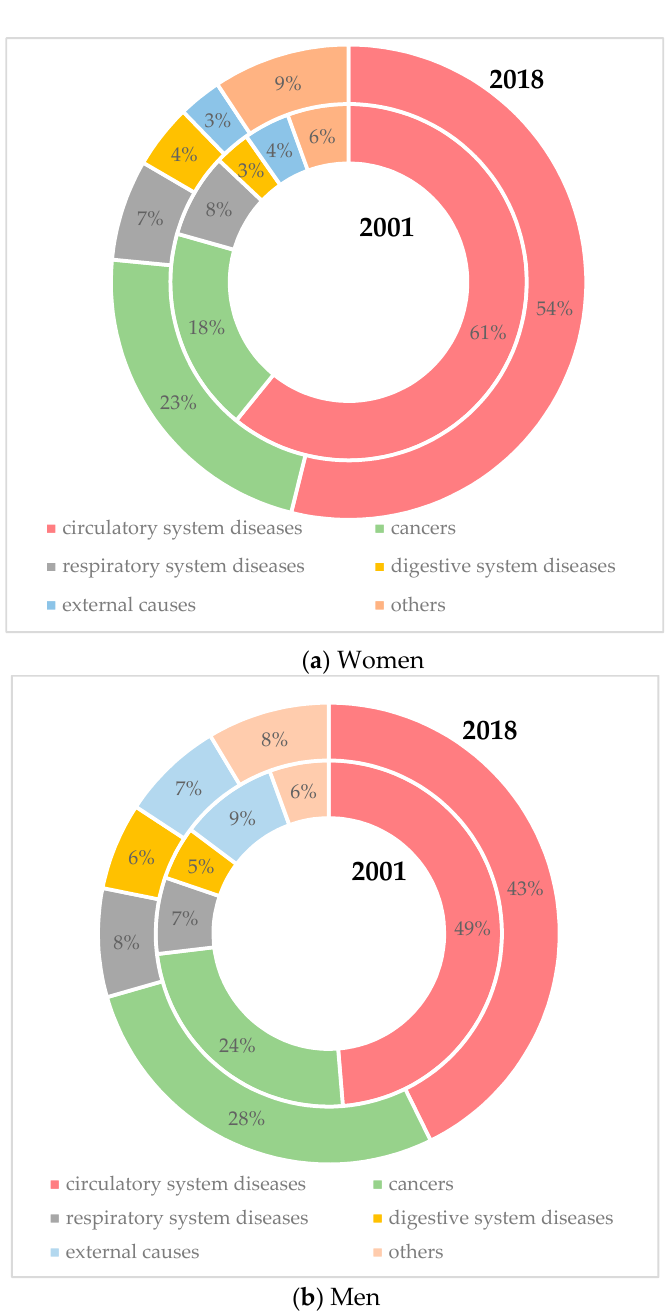
Figure 1. Population mortality by causes of death. Source: Statistical Office of the Slovak Republic, 2019.